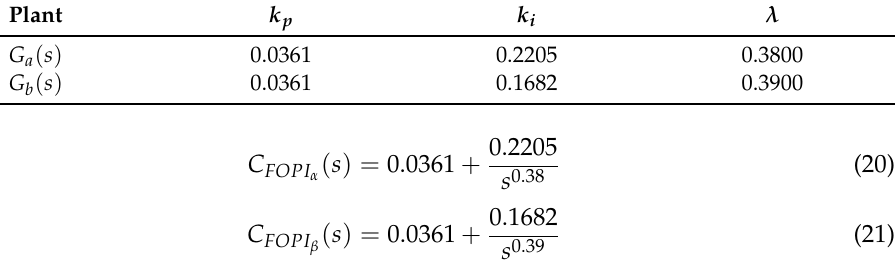
Table 2. FOPI controller parameters for φ m = 60 o and ω gc = 1.5 rad/s.